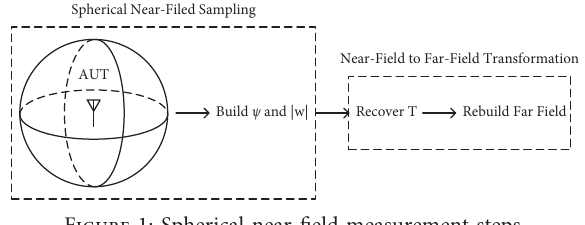
Figure 1: Spherical near-field measurement